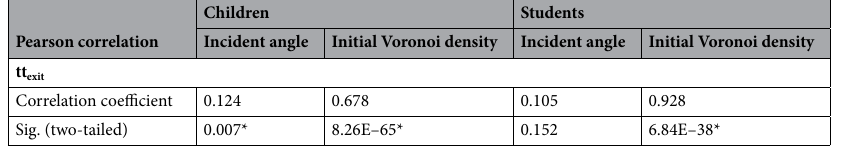
Table 8. Correlation results between travel time and incident angle/initial Voronoi density in the exit region of children’s and students’ experiments. *at 0.01 level (two-tailed), the result is significant.